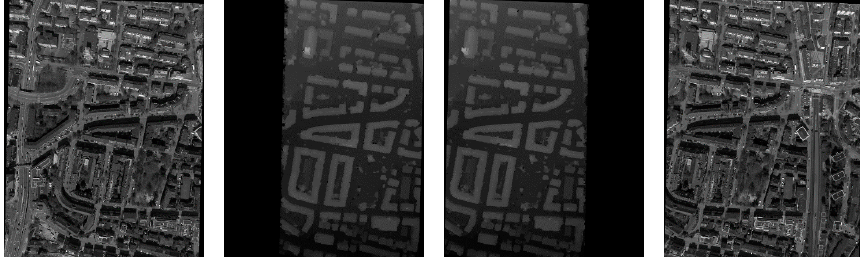
Figure 4. Stereo dense matching results for epipolar images (From left to right: left epipolar, left disparity, right disparity, and right epipolar images).